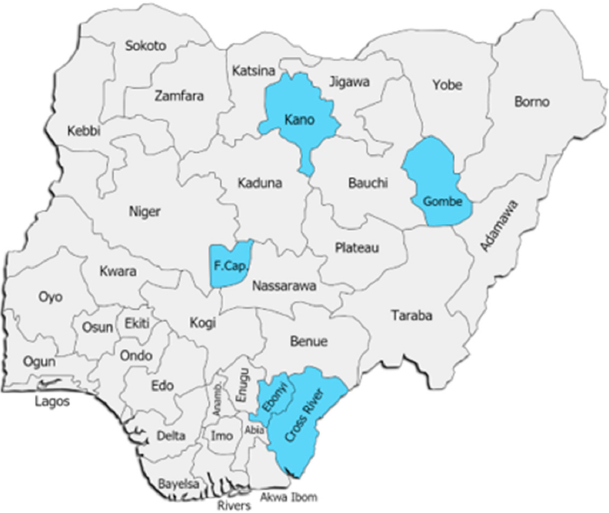
Figure 2. Map of Nigeria showing the states where the communities covered are